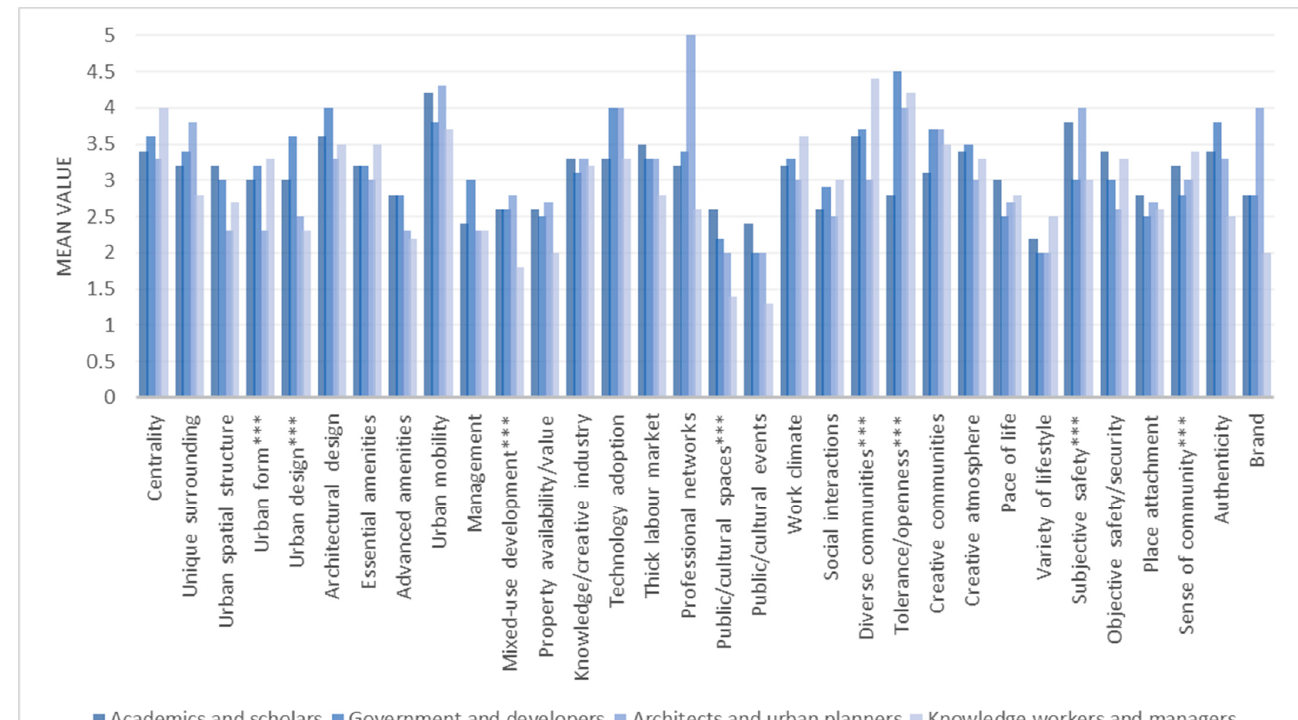
Figure 3. Quantitative evaluation of place characteristics in Brisbane Technology Park. In total, 278 valid Likert-scale questionnaires from the public across Brisbane were initially identi fi ed. Then, 55 questions collected from each participant were classi fi ed